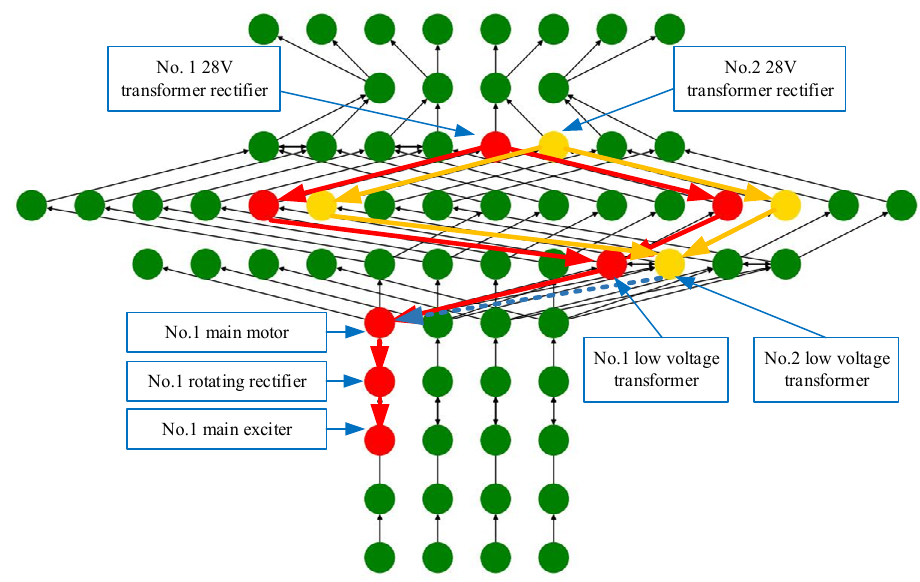
Figure 9. Example graph of phase-to-phase short-circuit fault backtracking of exciter armature winding.